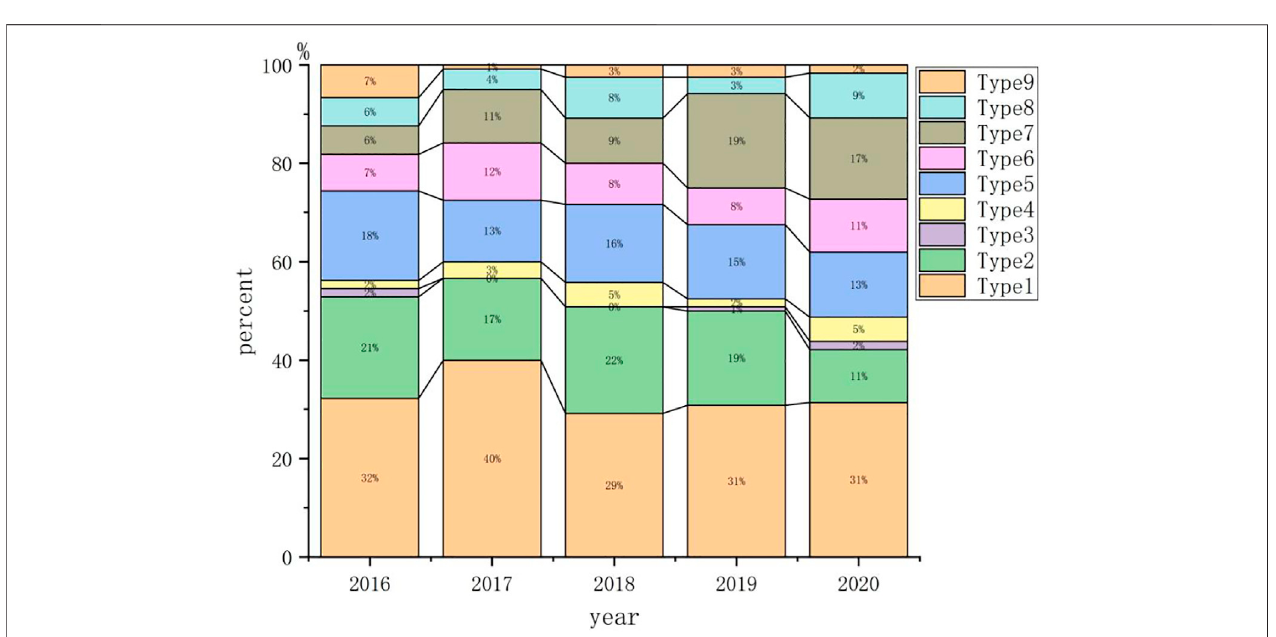
FIGURE 6 | Proportions and changing trends of the nine circulation patterns during the SP